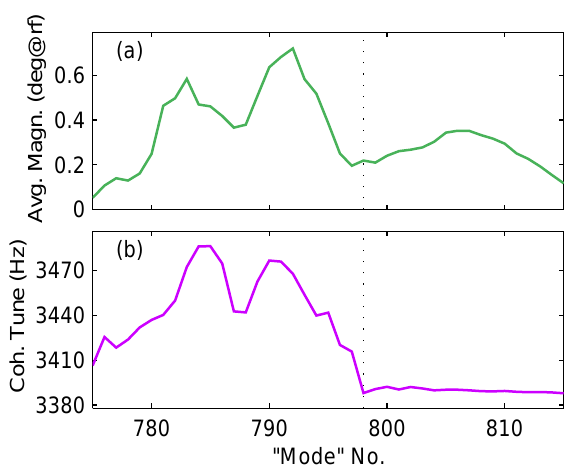
FIG. 9. (Color) Modal phase space trajectories of growing PEP-II LER longitudinal instability (same data as Fig. 8). (a) Representative selection of modes above m (cid:1) 798 . Ex- panding spirals about the origin indicate a single uneven-fill eigenmode. (b) Trajectories of a few modes below m (cid:1) 798 , whose magnitude transients show